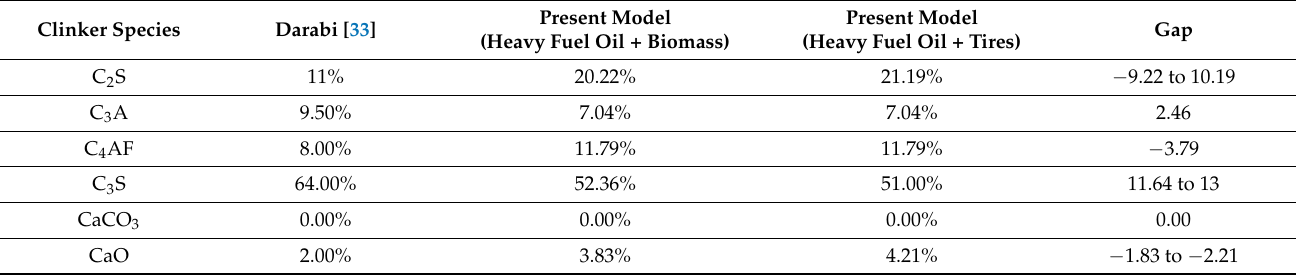
Table 11. Simulation